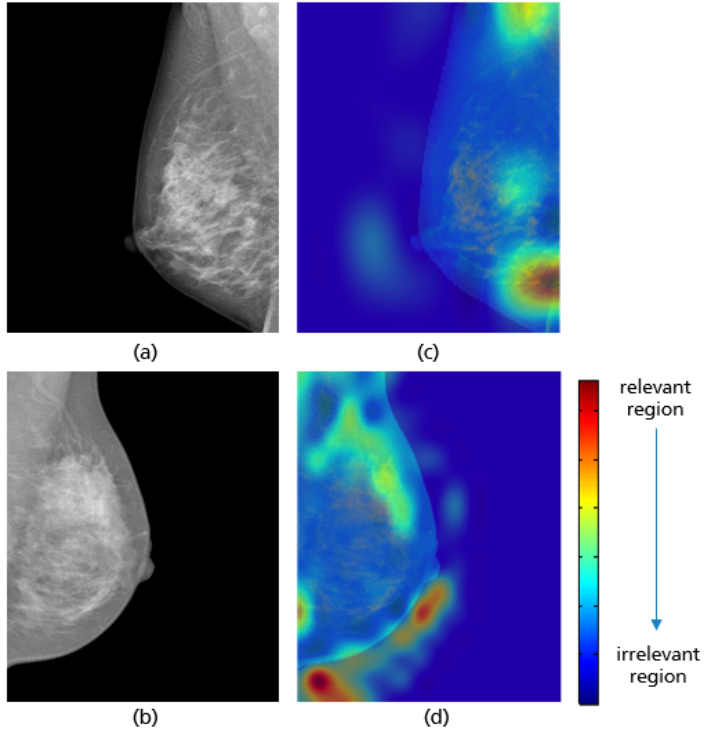
Figure 19. MLO view misclassified by the CNN model due to a low contrast ( a ) and the absence of retroglandular tissue ( b ), the corresponding CRAD-CAM visualizations ( c , d ).